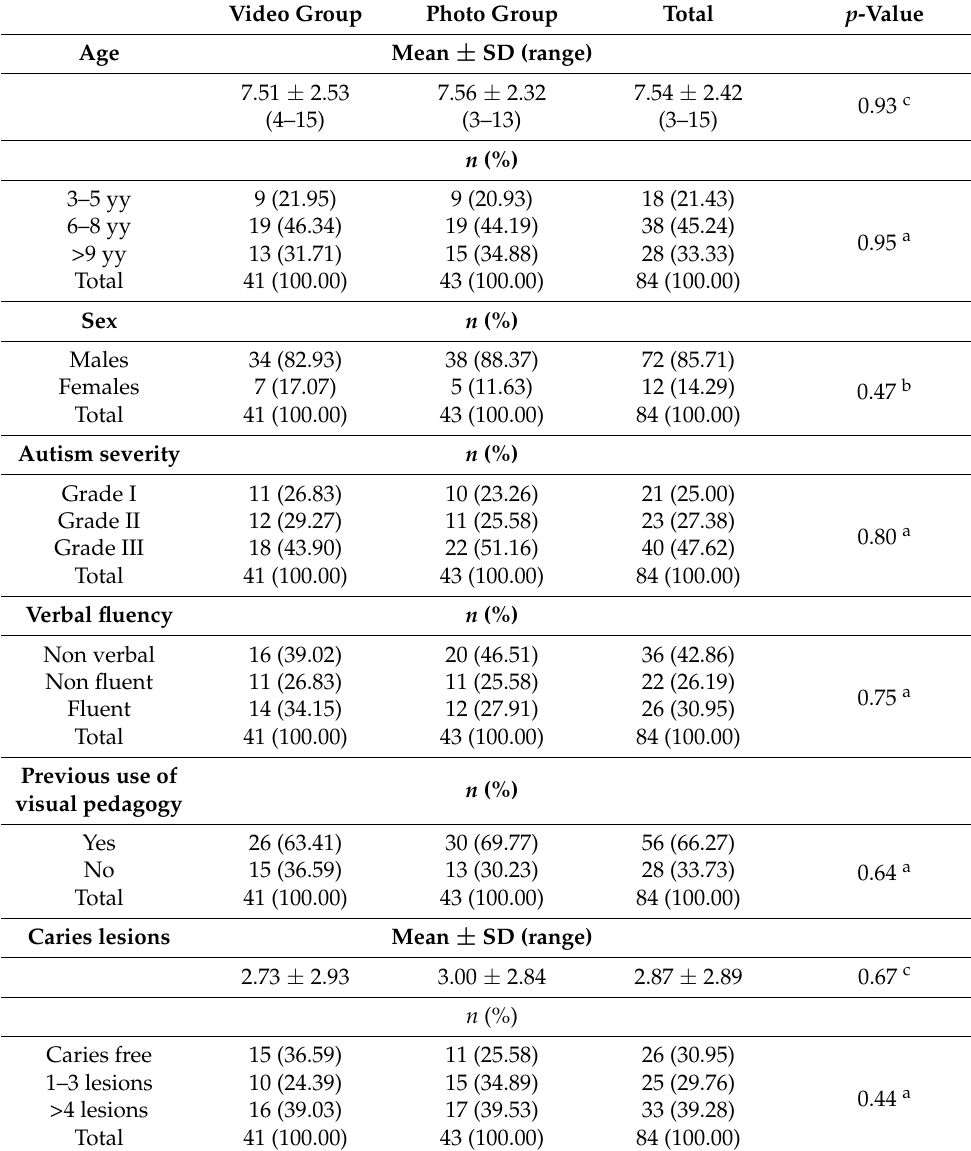
Table 1. Vital statistics including age, sex, autism severity, verbal fluency, previous use of visual pedagogy tools and caries status of the two